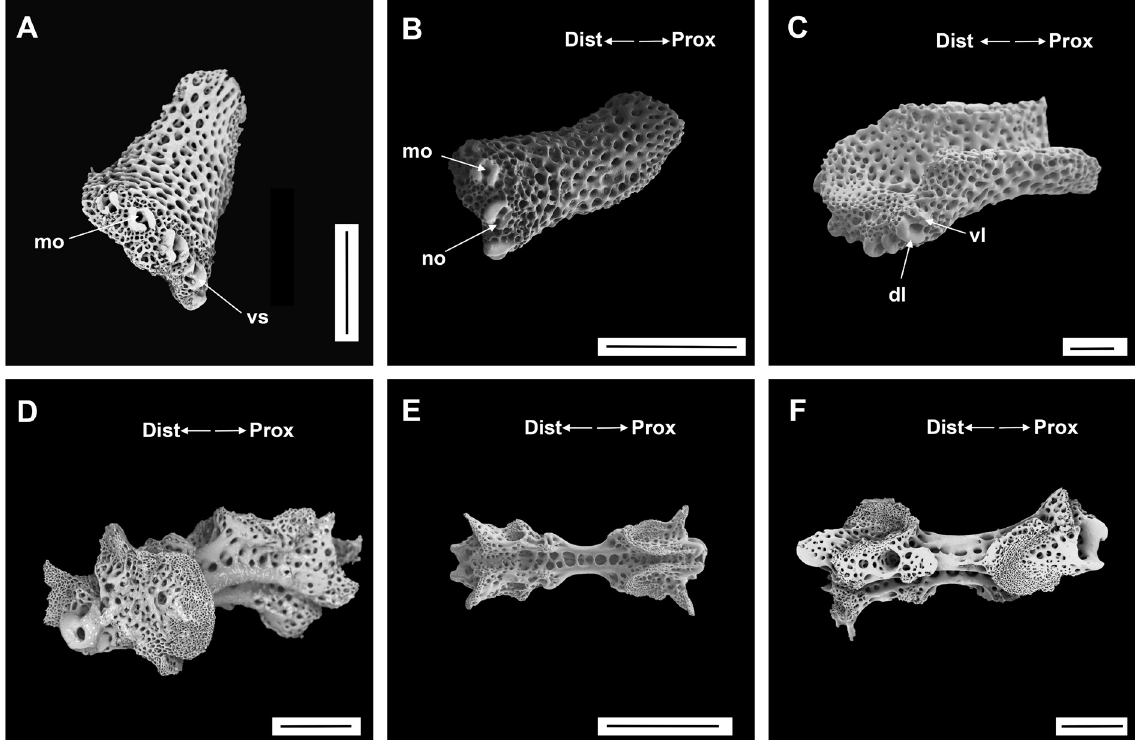
Fig. 35. Ophiomoeris petalis sp. nov., SEM, paratype (IDSSE EEB-SW0031). A–C . Lateral arm plate. D–F . Vertebrae. D . Dorsolateral view. E . Ventral view. F . Lateral view. Abbreviations: Dist = distal; dl = dorsal lobe; mo = muscle opening; no = nerve opening; Prox = proximal; vl = ventral lobe; vs = volute-shaped. Scale bars: A–B, E = 200 µm; C–D, F = 100